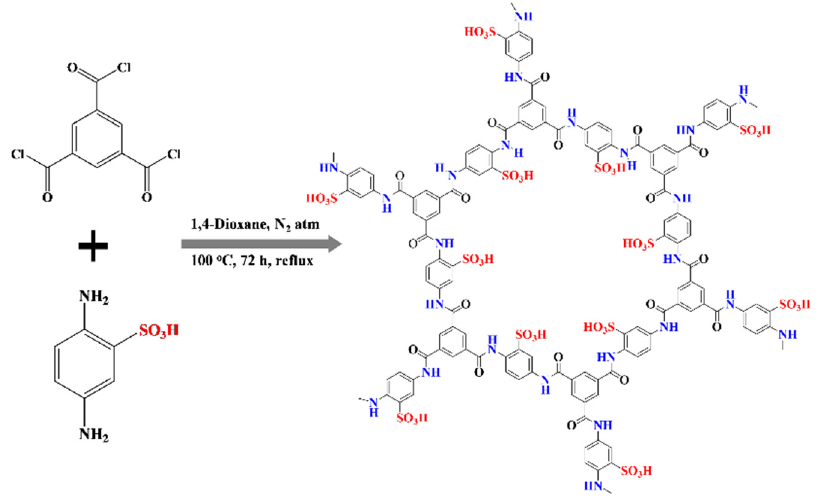
Figure 1. Synthetic scheme of PA-PhSO 3 H .